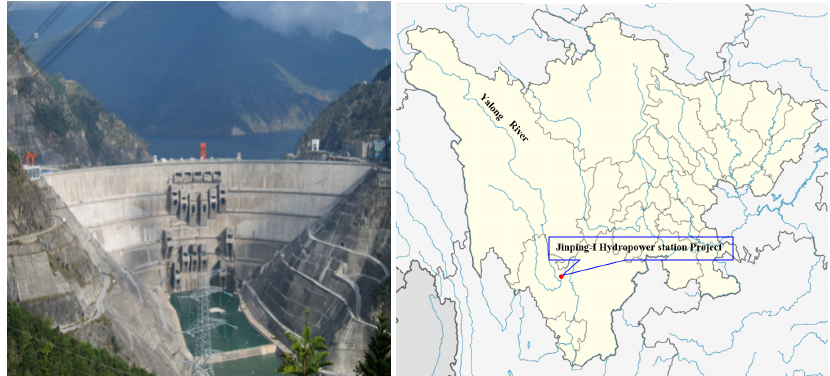
Figure 4. Picture of the selected concrete arch dam and its